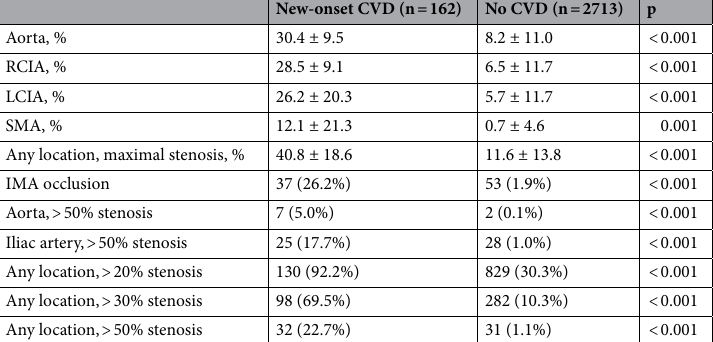
Table 5. Degree of arterial stenosis. CVD cardiovascular disease, IMA inferior mesenteric artery, LCIA left common iliac artery, RCIA right common iliac artery, SMA superior mesenteric